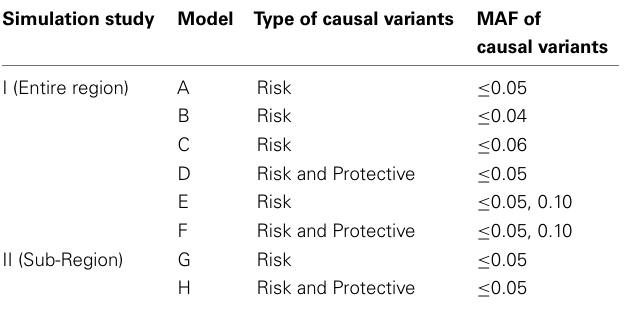
Table 2 | Number of risk (protective) variants per region in each simulation